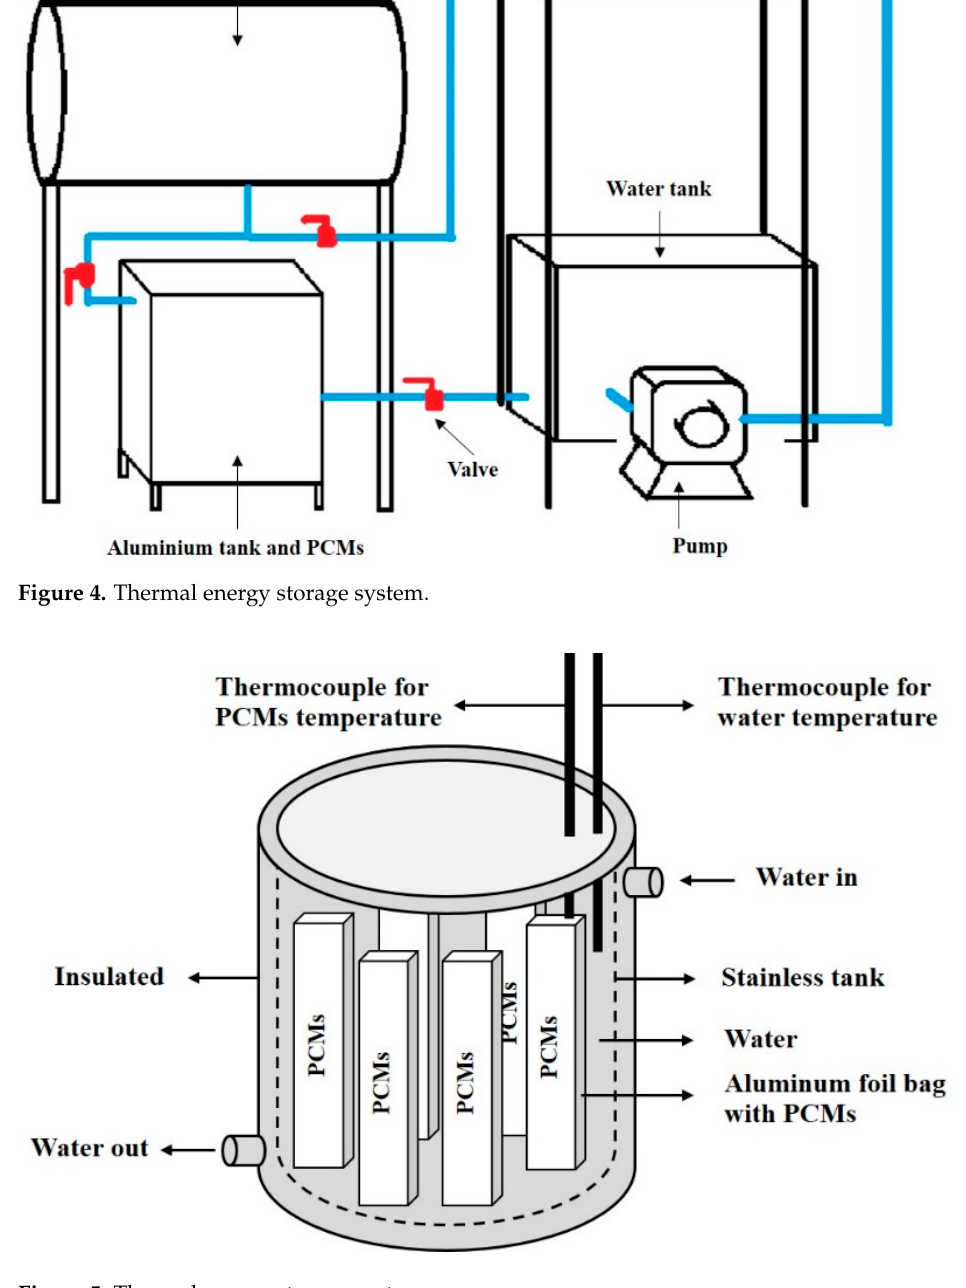
Figure 5. Thermal energy storage system.